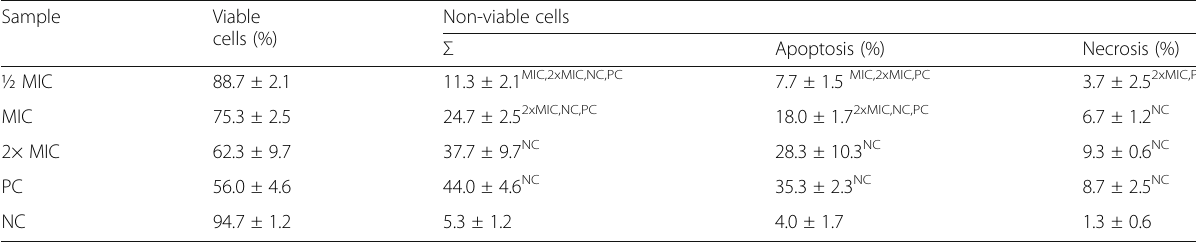
Table 1 Results of the quantitative fluorescent assay for simultaneous identification of apoptotic and necrotic cells in C. albicans ATCC 90028 treated with berberine in vitro for 3 h